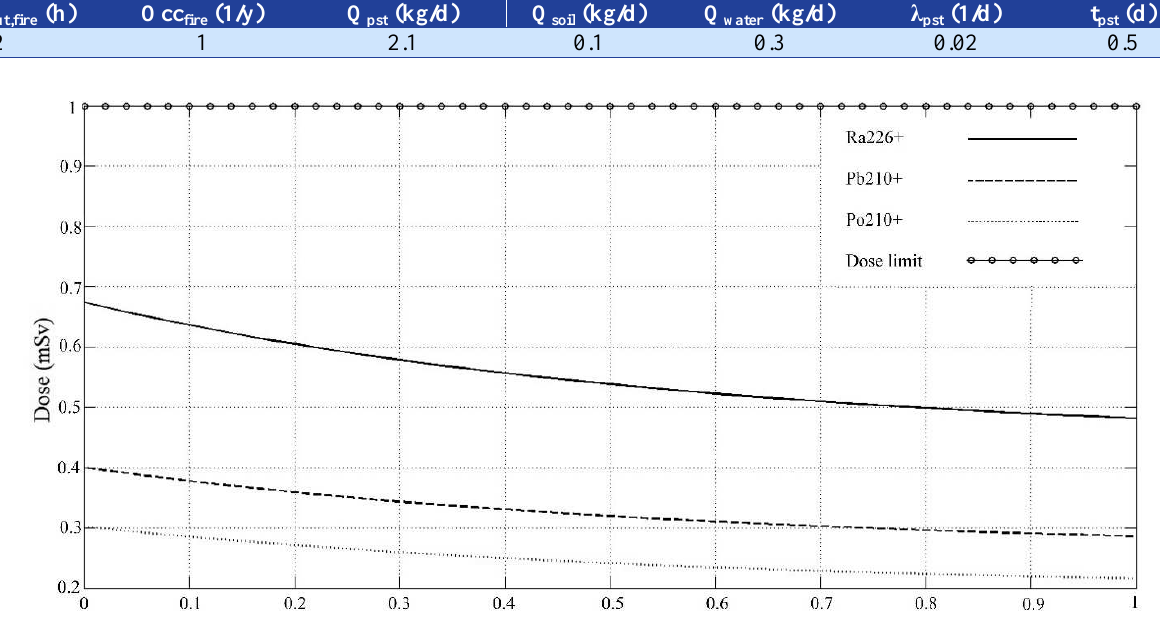
Table 2. Exposure term characteristics for an individual chinkara t (h) out,fire